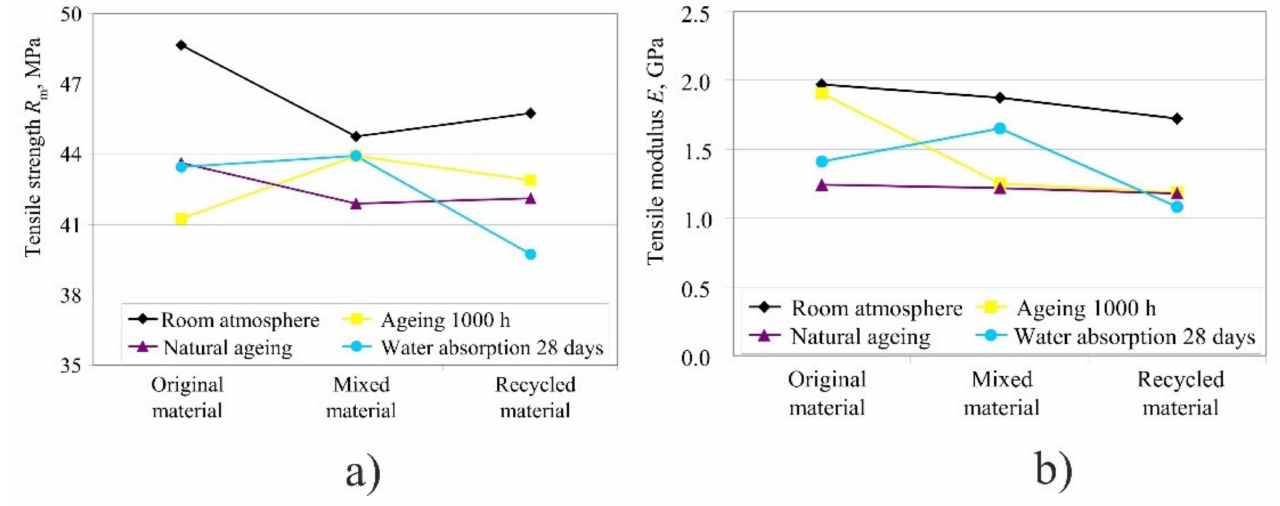
Figure 18. Impact of weathering conditions on tensile strength and modulus in different types of materials: ( a ) diagram for tensile strength, ( b ) diagram for tensile